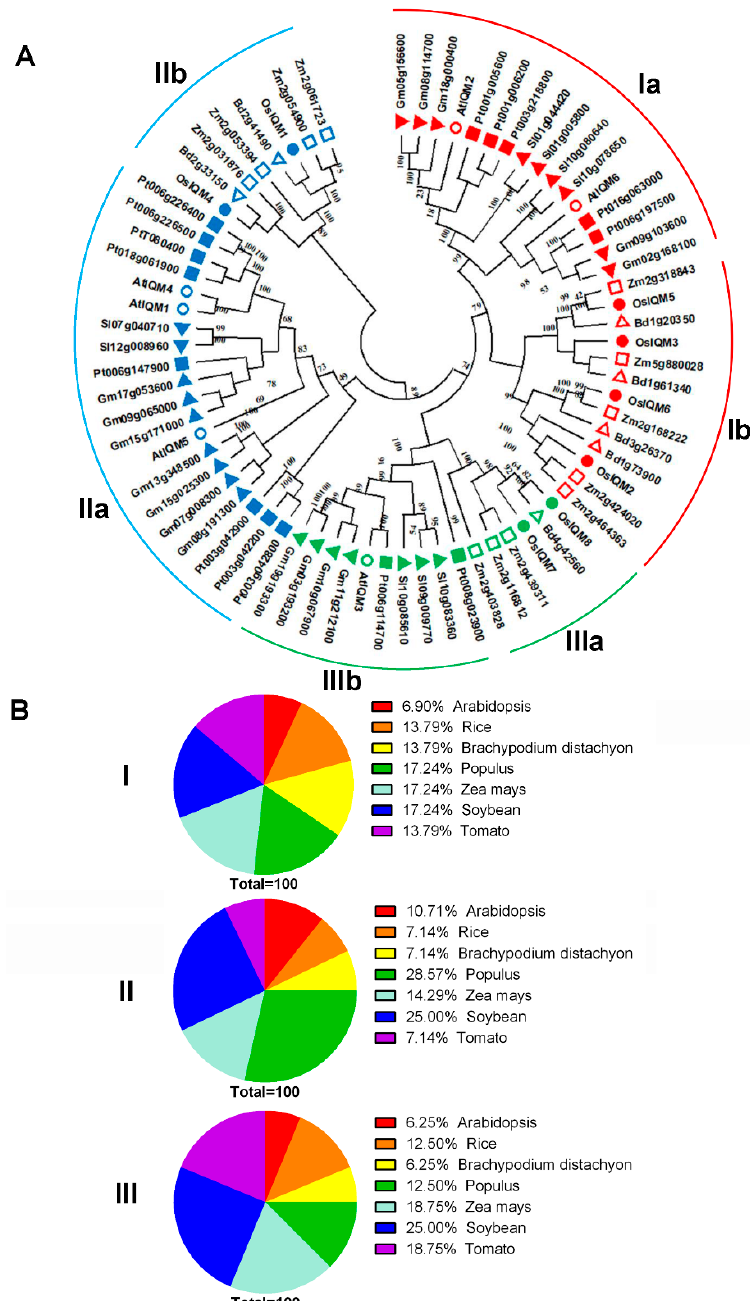
Figure 1. Phylogenetic tree and distribution of IQM protein from 7 plant species. ( A ) The full-length amino acid sequences of the IQM proteins from Brachypodium distachyon , Oryza sativa , Arabidopsis thaliana , Populus trichocarpa , Zea mays , Glycine max and Solanum lycopersicum were aligned using ClustalX 1.83, and the phylogenetic tree was constructed by the NJ method with MEGA X. The number of bootstrap values was 1000 replicates. Red—subfamily I; blue—subfamily II; green—subfamily III. IQM proteins from the same species were marked with geometrical patterning: hollow circle— Arabidopsis thaliana ; filled circle— Oryza sativa ; hollow triangle— Brachypodium distachyon ; filled inverse-triangle— Glycine max ; filled triangle— Solanum lycopersicum ; filled quadrate— Populus trichocarpa ; hollow quadrate— Zea mays . ( B ) A percentage representation of IQM proteins across the plant species in each subfamily.